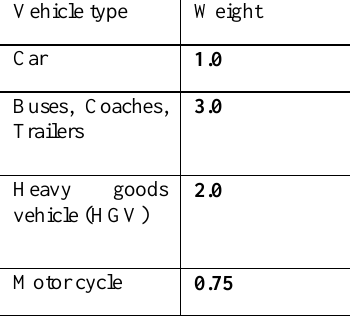
Table 6: weighting conversion to P.C.U